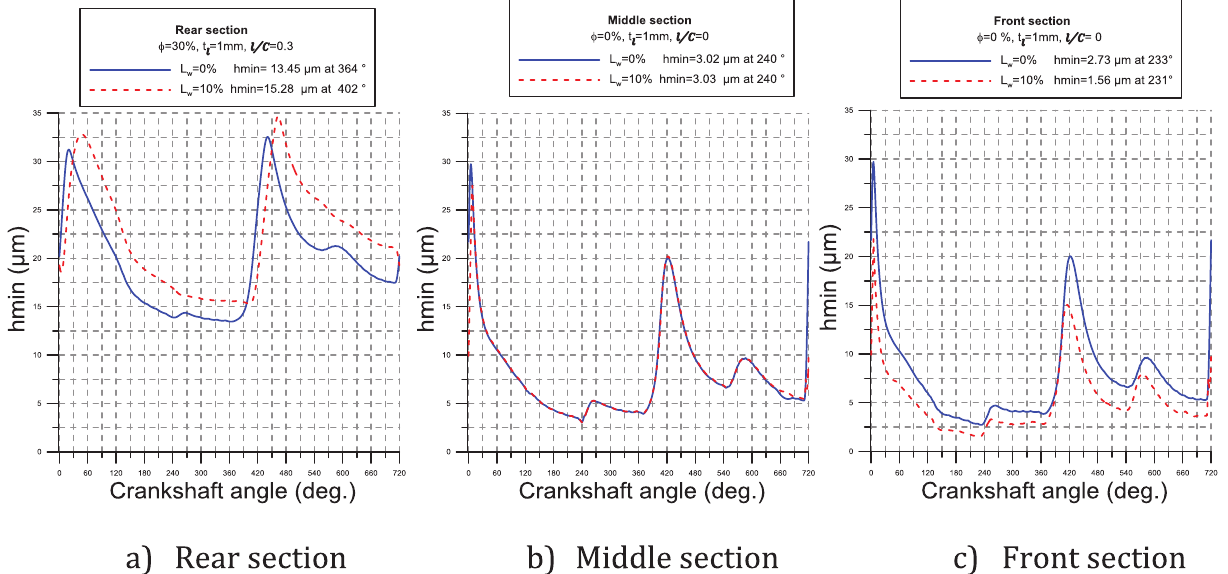
Fig. 9. Effects of the dynamic misalignment parameter L W on the minimum fi lm thickness over an engine cycle for the Newtonian case.